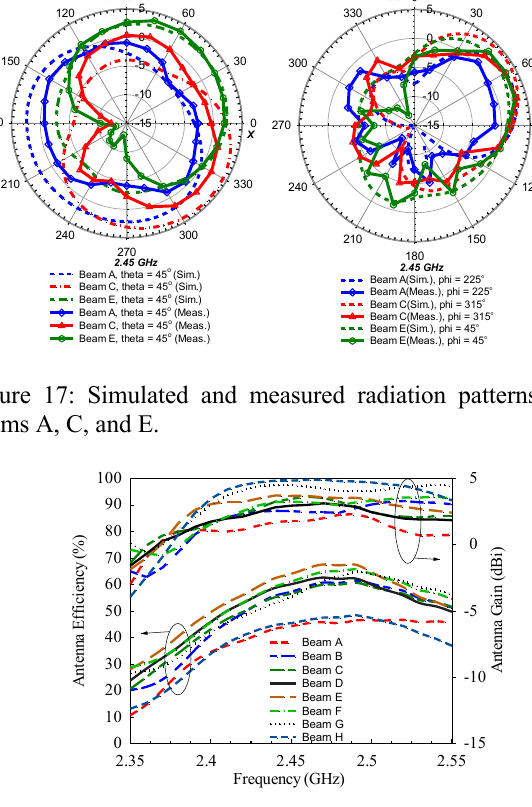
Figure 18: Measured antenna gains and efficiencies vs frequency for beams A to